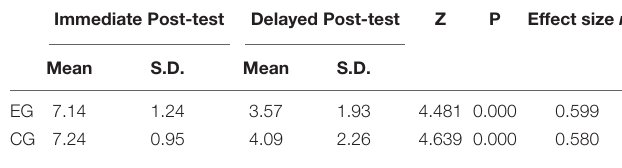
TABLE 5 | Independent samples t -test of delayed post-test in the EG and the CG.